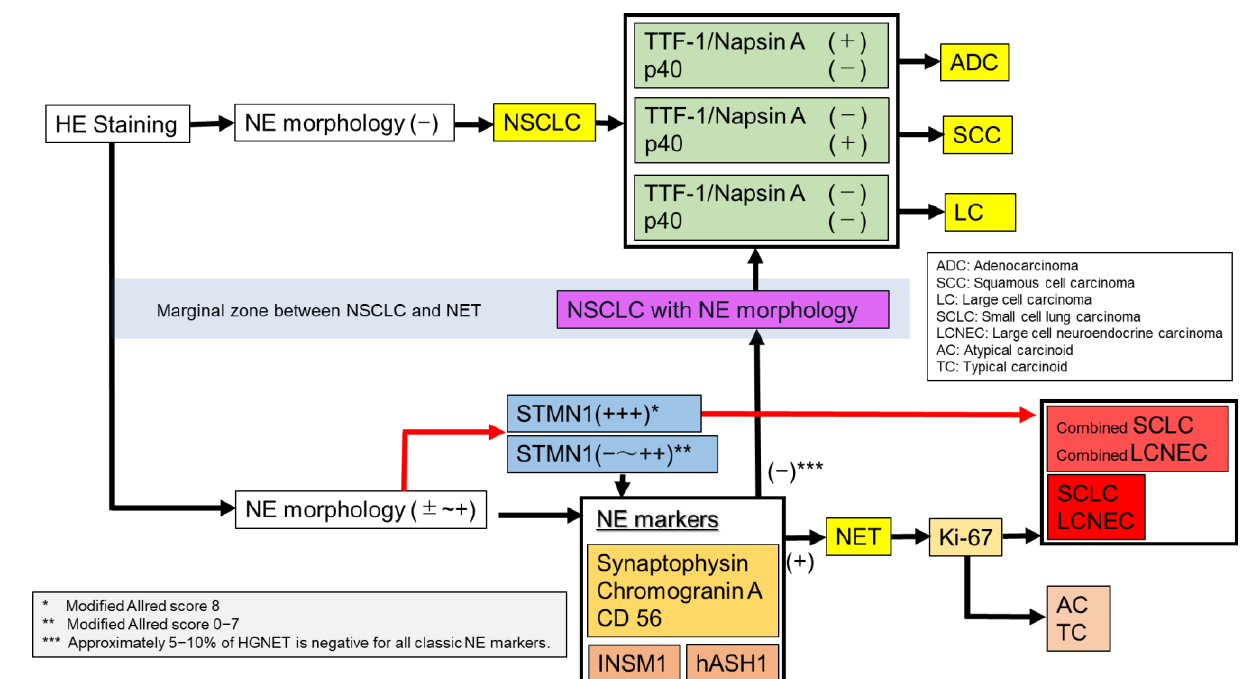
Figure 3. A flow chart for diagnosis of lung cancer.